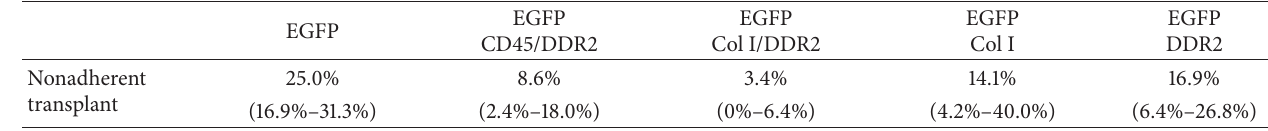
Table 2: Heterogeneity of EGFP cells in lungs of transplanted animals.